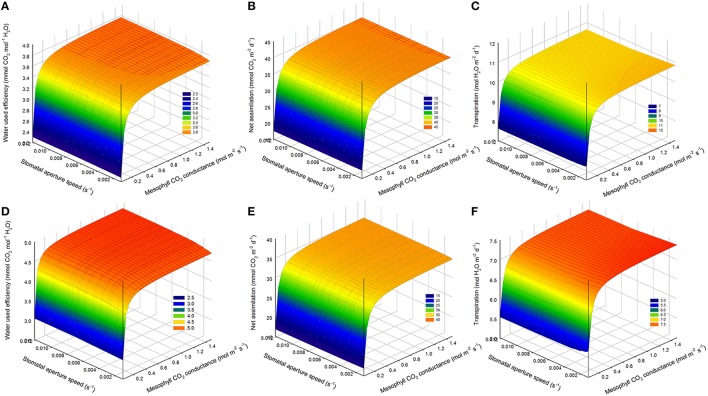
Combined effect of increasing mesophyll CO2 conductance (gm) and stomatal speed (αg) on daily water use efficiency (WUE). (A,D) daily WUE for different values of gm and αg for a cucumber leaf during the recorded sunny (A) and cloudy (D) days. (B,E) total daily transpiration rate (FO) during the recorded sunny (B) and cloudy (E) days for different values of gm and αg. (C,F) total daily net assimilation rate (Anet) during the recorded sunny (C) and cloudy (F) days for different values of gm and αg. Simulations were performed per second over 15 h (from 06:00 a.m. to 9:00 p.m.). Values of gm = 0.3 was increased from −40 to 500% and αg was varied in a set of 15 values and the figure present daily simulation result. Other climatic data were extracted from the 2 days measurement data presented in Figure 1 and all other parameter values are summarized in Tables 1, 2.